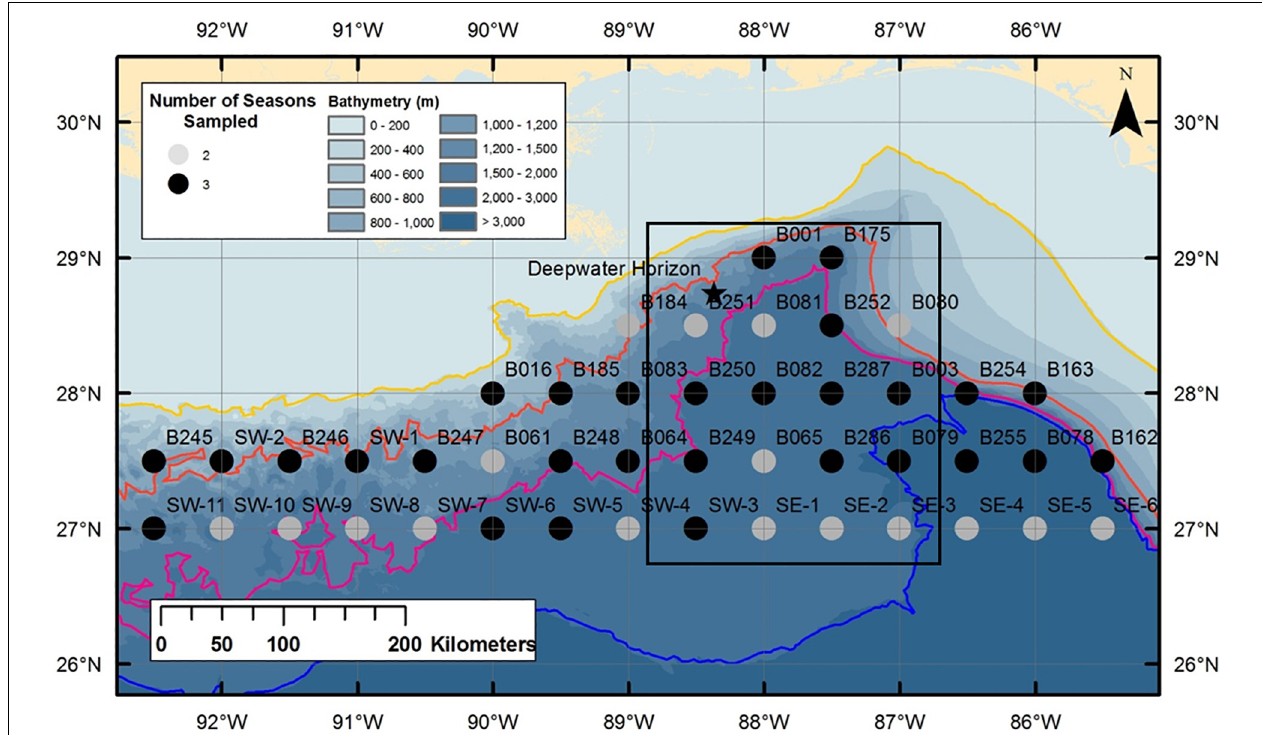
FIGURE 1 | Station sites for ONSAP and DEEPEND MOC10 cruises. Modified from Florida Fish and Wildlife Research Institute SEAMAP cruise stations. Circles, ONSAP stations; black box, DEEPEND stations; star, DWH oil spill site.